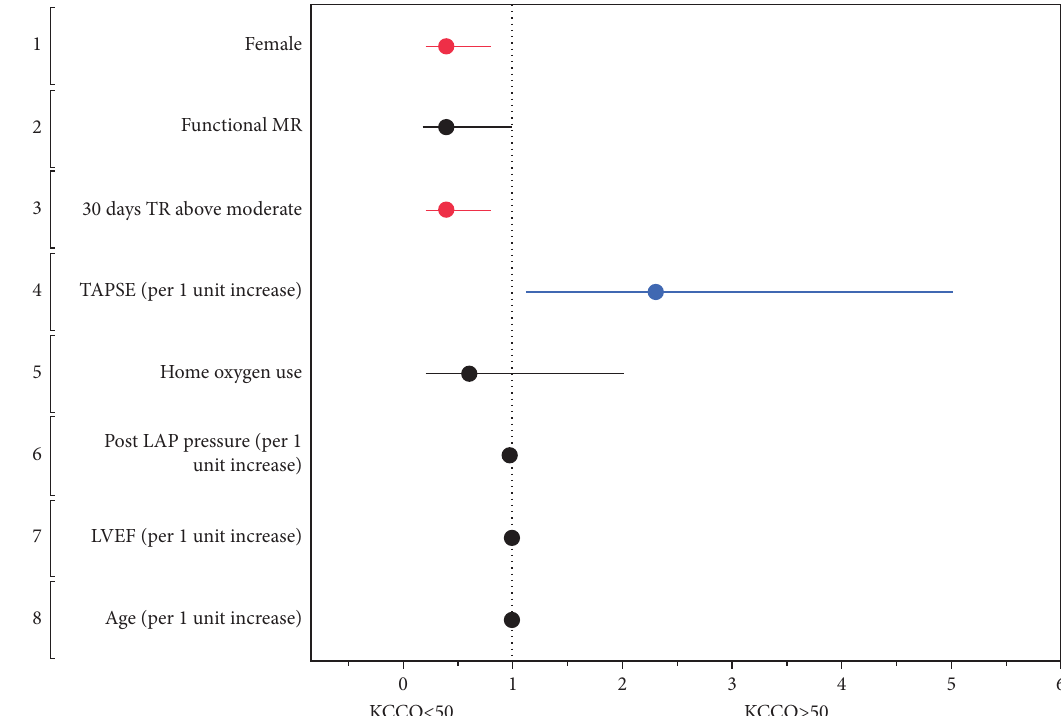
Figure 5: Clinical predictors of low KCCQ score among patients with procedural success represented by a forest